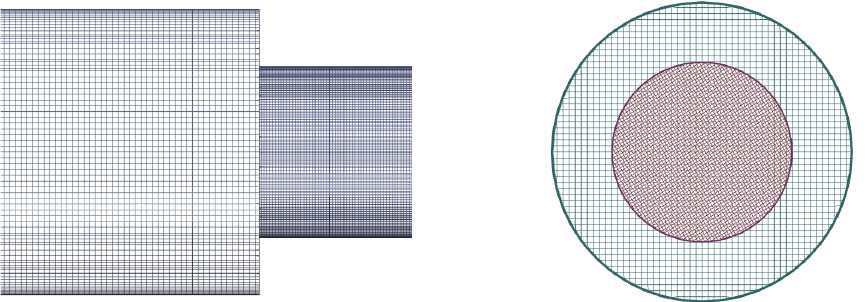
Figure 8. Unmatched grid fragments in the longitudinal and lateral sections.